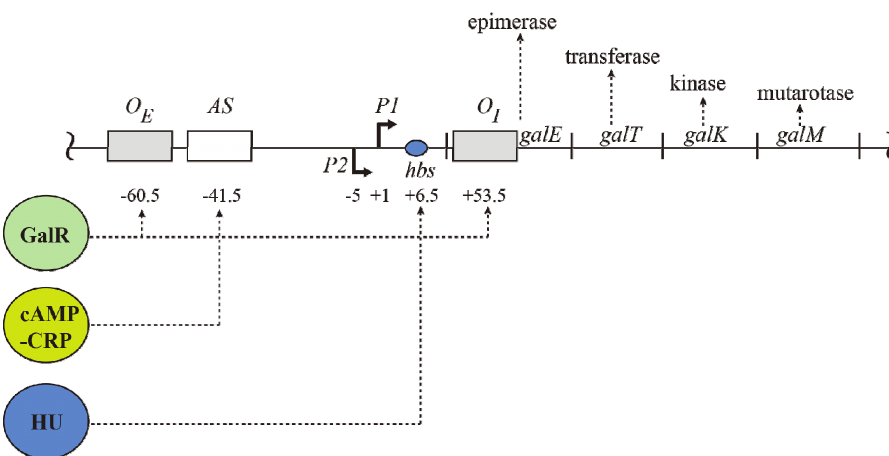
Figure 1. The gal operon. The gal structural genes, gal ETKM, encode the enzymes epimerase, transferase, kinase and mutarotase, respectively. The transcription start point ( tsp ) of P1 is +1 and that of P2 is (cid:2)5 The numbering system is relative to +1, with numbers downstream of +1 as positive (+) and numbers upstream as negative ((cid:2)). Operators ( O E & O I ), hbs : HU binding site, AS: activating site. GalR (green) binds to two operators ( O E & O I ). HU (blue) binds to the HU binding site ( hbs ) and cAMP-CRP (yellow) complex binds to the activating site (AS). The map is not drawn to